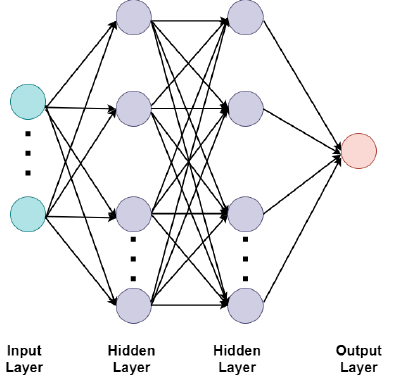
Figure 2. The MLP architecture [23].